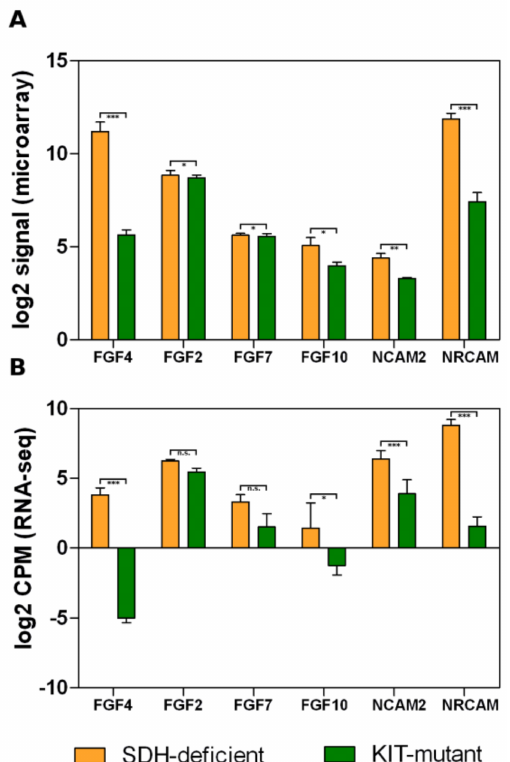
Figure 2. Box plots showing differences in expression levels of FGFs and NCAMs for the microarray series ( A ) and RNA-seq series ( B ). Orange boxes represent SDH-deficient GISTs; green boxes represent KIT-mutant GISTs. Significance level: *** p -value < 0.001; ** 0.001 ≤ p -value < 0.01; * 0.01 ≤ p -value < 0.05; n.s., not